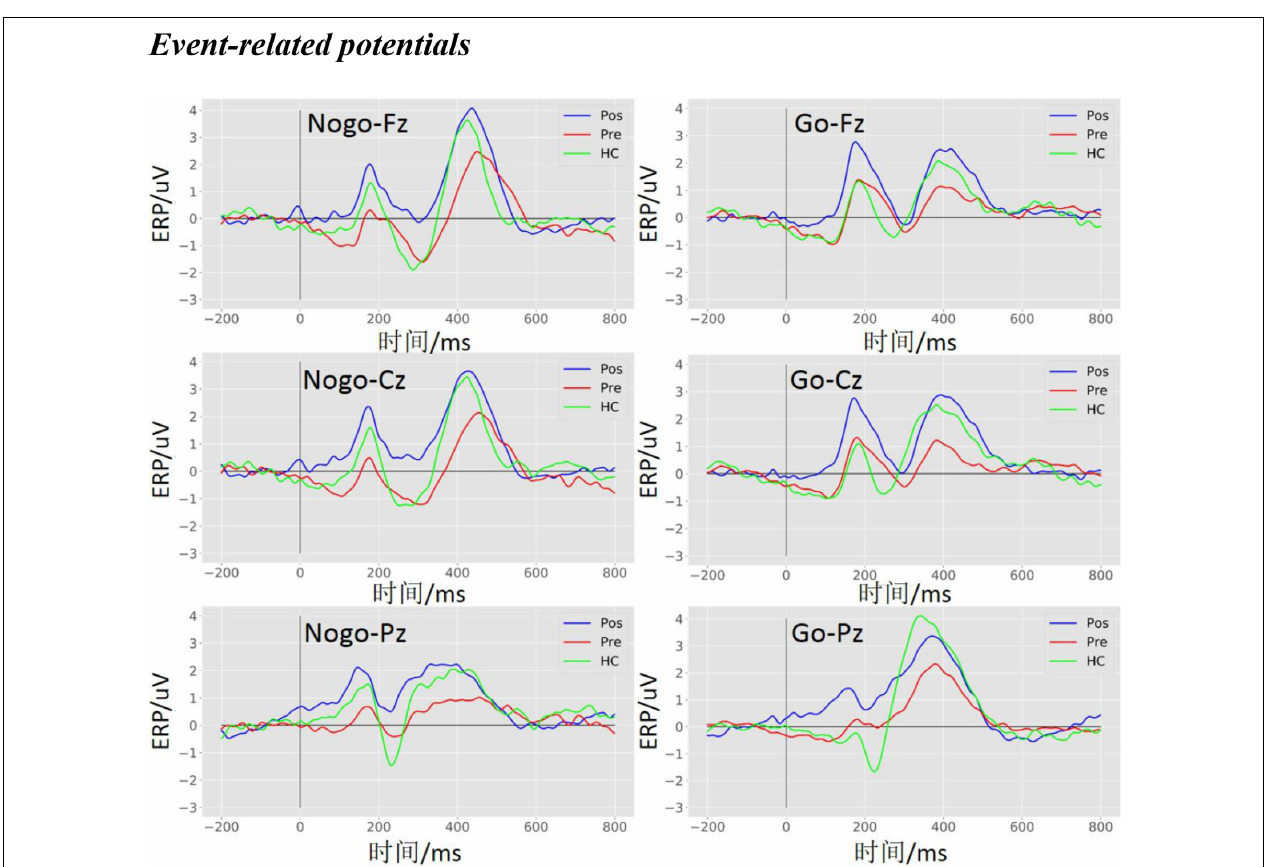
FIGURE 3 | Event-related potentials (ERPs) waveform at the Fz, Cz, and Pz electrodes. The grand average ERPs waveform with three groups (pre, pre-operative group; post, post-operative group; HC, healthy control group) in the Nogo condition (left panel) and the Go condition (right panel) at the Fz, Cz, and Pz electrodes,